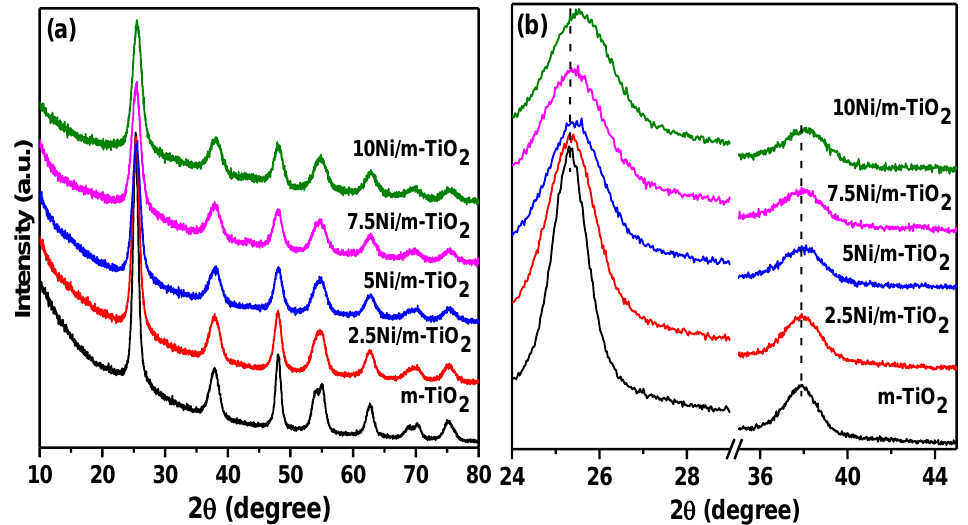
Figure 1. ( a ) XRD patterns of different wt.% of Ni/m-TiO 2 catalysts. ( b ) expanded view of XRD patterns in 2 θ from 24 º to 44 ° for different wt.% of Ni/m-TiO 2 catalysts FT-IR spectroscopy was used to investigate the surface functional groups of the pure and Ni incorporated m-TiO 2 after the annealing process. In Figure 2a, all the samples showed weak absorption peaks at 3327 cm −1 and 3444 cm −1 due to hydroxyl stretching frequency from adsorbed water [36]. The second adsorption peak at 1637 cm −1 corre- sponds to OH bending frequency [37]. The peak at 650 cm −1 may be attributed to the stretching and bending vibration mode of Ti-O [38]. From the spectra of pure m-TiO 2 and Ni-doped m-TiO 2 , it is noticed that the Ti-O bond peak was slightly shifted to a lower wavenumber and changed in the intensity of peak (Figure 2b), likely due to the presence of the Ni 2+ ions in the interstitial sites of the crystal lattice [39], which was also consistent with the XRD results (see Figure 1). No other additional peaks are observed related to an organic moiety after calcining samples. It indicates that the addition of P123 and nitrate